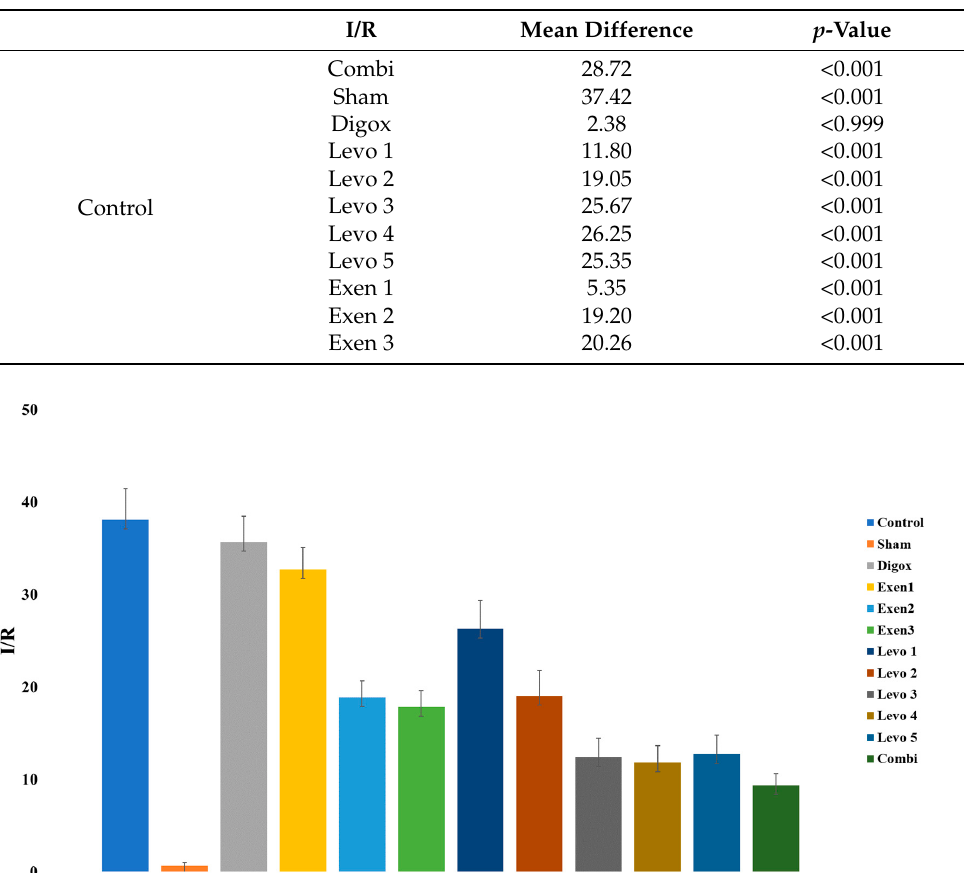
Table 17. Pairwise comparisons for Ischemia/R among groups.